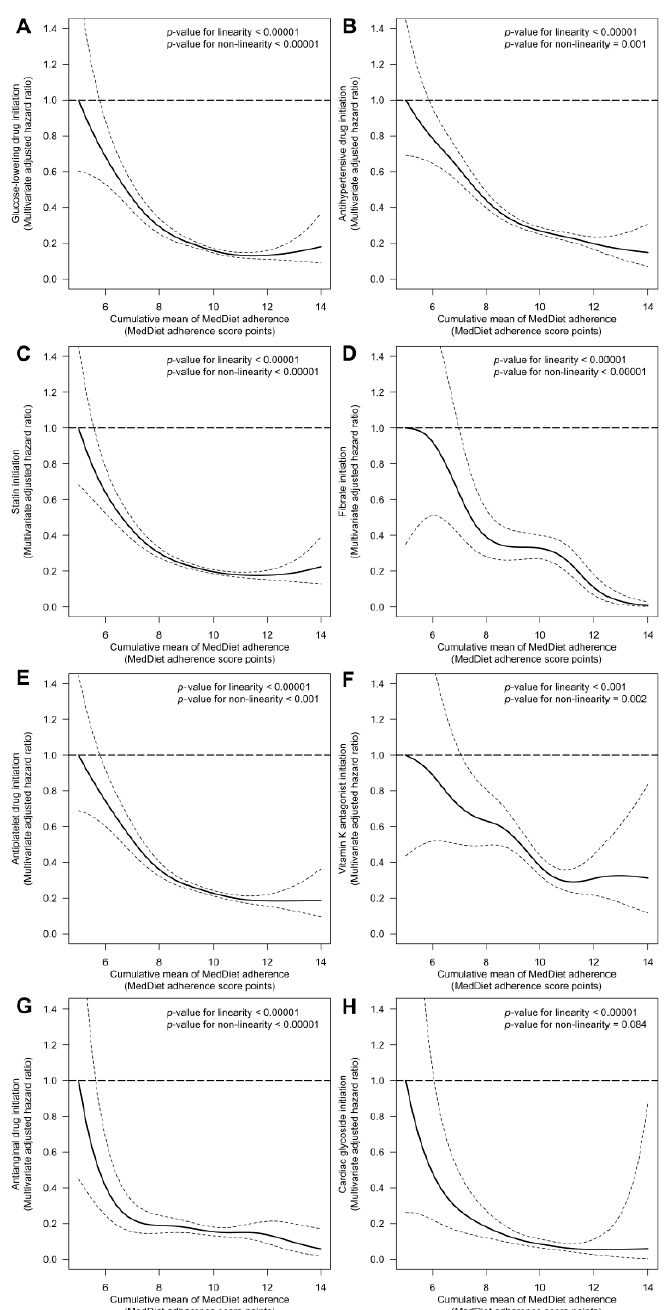
Figure 2. Association between long-term adherence to a MedDiet and the risk of initiating glucose- lowering ( A ), antihypertensive ( B ), statin ( C ), fibrate ( D ), antiplatelet ( E ), vitamin K epoxide reductase inhibitors ( F ), antianginal ( G ), and cardiac glycoside ( H ) therapies. Cox proportional hazards regression models with cubic splines were stratified by sex, recruitment site, and educational level, and adjusted for: age, diabetes, hypercholesterolemia, hypertriglyceridemia, hypertension, smoking habit, body mass index, alcohol consumption, energy intake, leisure-time physical activity, and PREDIMED intervention group. We substituted diabetes for fasting glucose in the analysis on glucose-lowering therapy initiation, hypertension for systolic blood pressure in the analysis on antihypertensive therapy initiation, hypercholesterolemia for total cholesterol in the analysis on statin initiation, and hypertriglyceridemia for triglycerides in the analysis on fibrate initiation. We used robust variance estimators to account for intra-cluster correlations.